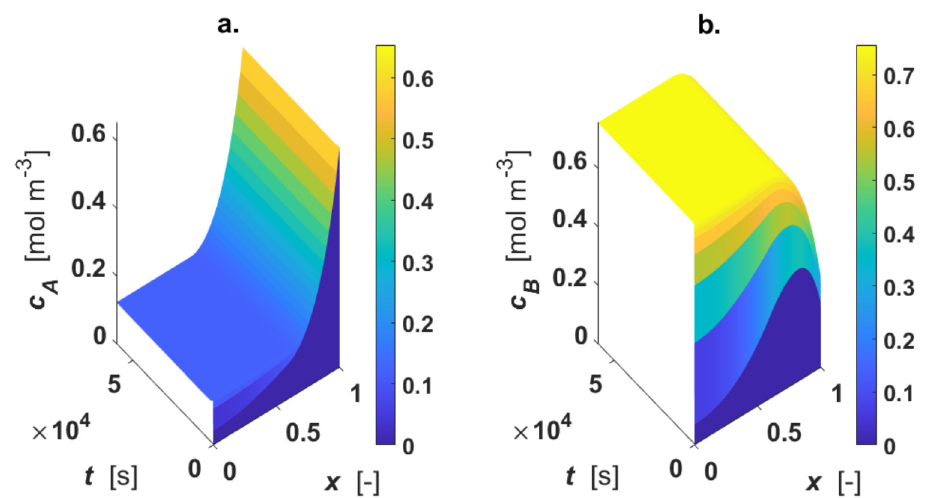
Figure 8. Intraparticle concentration and temperature profiles; k m = 1 m s −1 ; h = 4218 W m −1 K −1 . ( a ) concentration of A; ( b ) concentration of B. Color-bar of each plot is located on the right-hand-side.